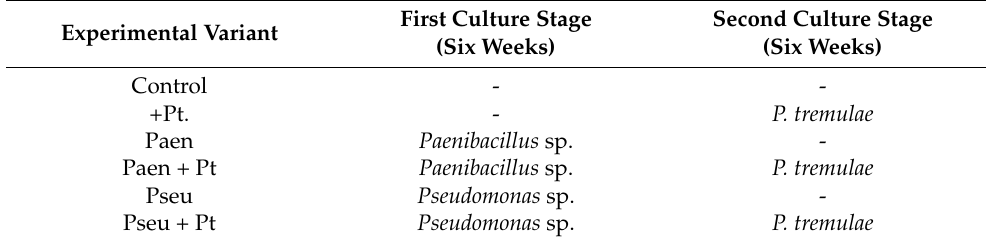
Table 1. Scheme of the inoculation experiments, indicating inoculation of plant nutrient medium with different microorganisms (bacteria that were determined to be Paenibacillus sp. and Pseudomonas sp. and fungus, Phellinus tremulae ) during two culture